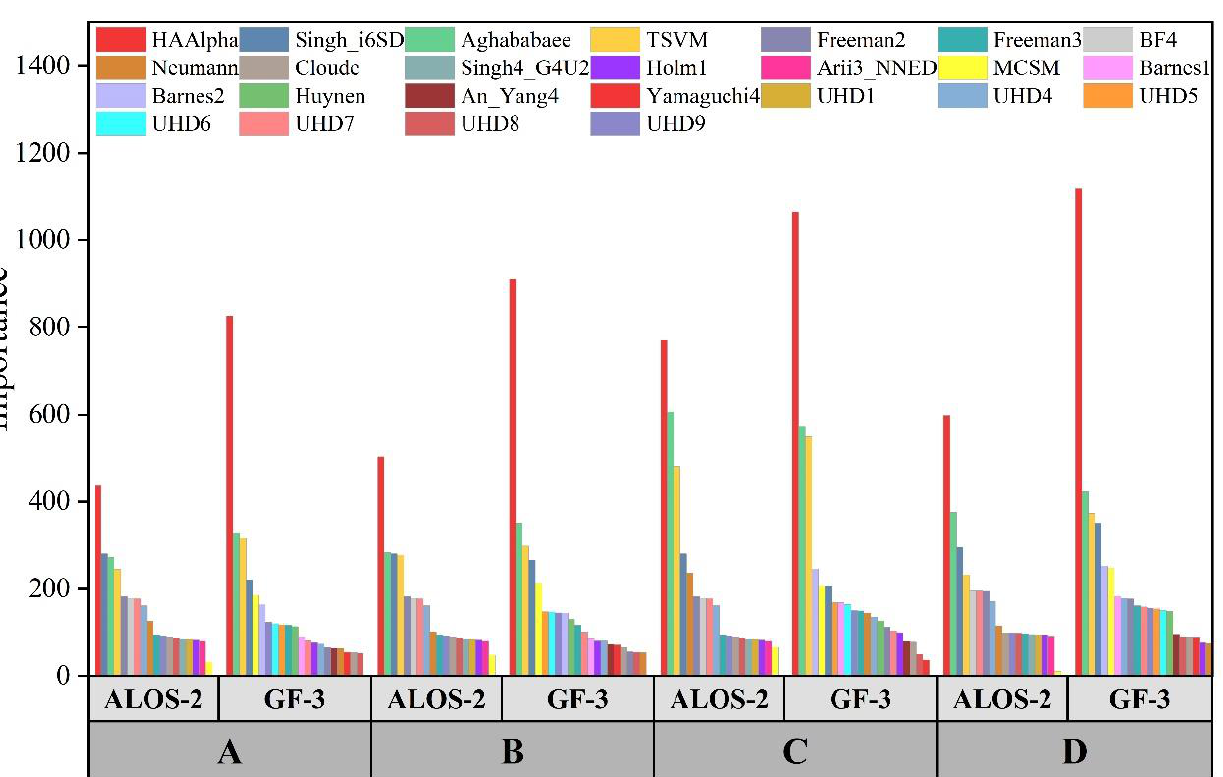
Figure 10. Contribution of polarimetric parameters of GF-3 and ALOS-2 to marsh vegetation classification using different decomposition methods. A, shrub; B, forest; C, deep-water marsh vegetation; D, shallow-water marsh vegetation.